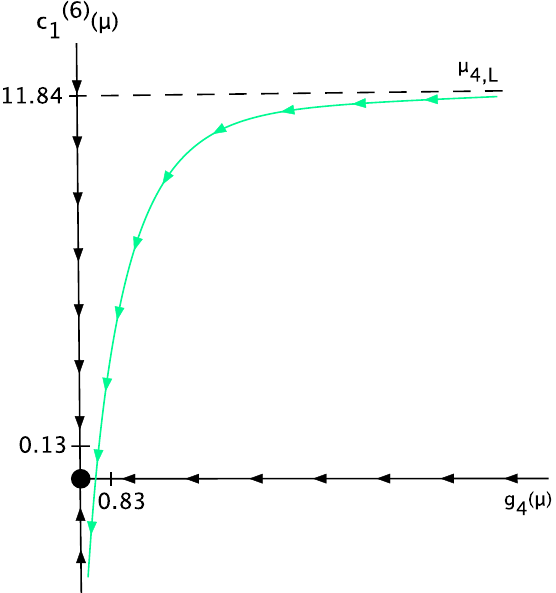
Fig. 4 The simultaneous running of the HDO and gauge couplings (μ) and g (μ) . The arrows point towards the IR, so both cou- c ( 6 ) 4 1 plings increase in the UV. As μ → 0 the Gaussian fixed point, • , is approached and then g 4 → 0 while the HDO coupling reaches −∞ . At the starting point of the running, μ = m R , the couplings ( 6 ) , g ) = ( 0 . 13 , 0 . 83 ) while in the UV, where g read ( c 4 , R 4 reaches the 1 , R ( 6 ) (μ ), g (μ )) = ( 11 . 84 , ∞ Landau pole μ 4 , L , yield ( c 4 , L 4 4 , L 1